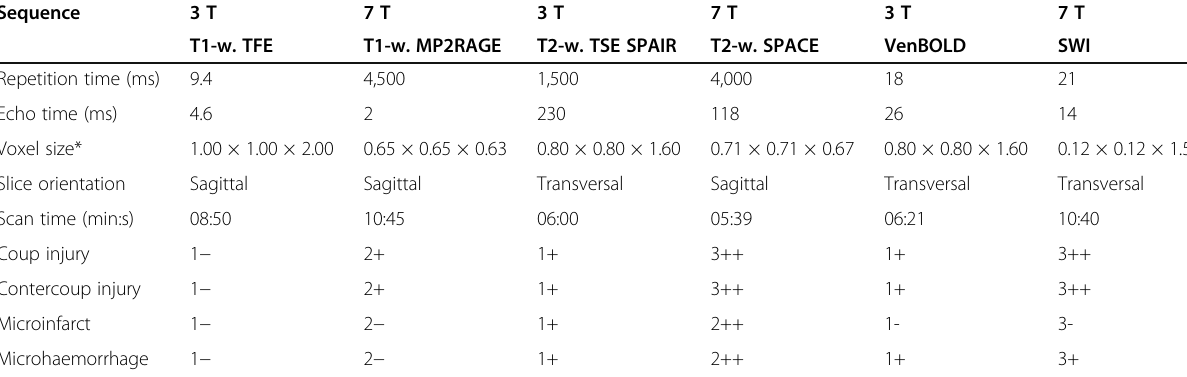
Table 1 3-T and 7-T protocols and radiologic assessment of coup/contrecoup injuries and microlesions Sequence 3